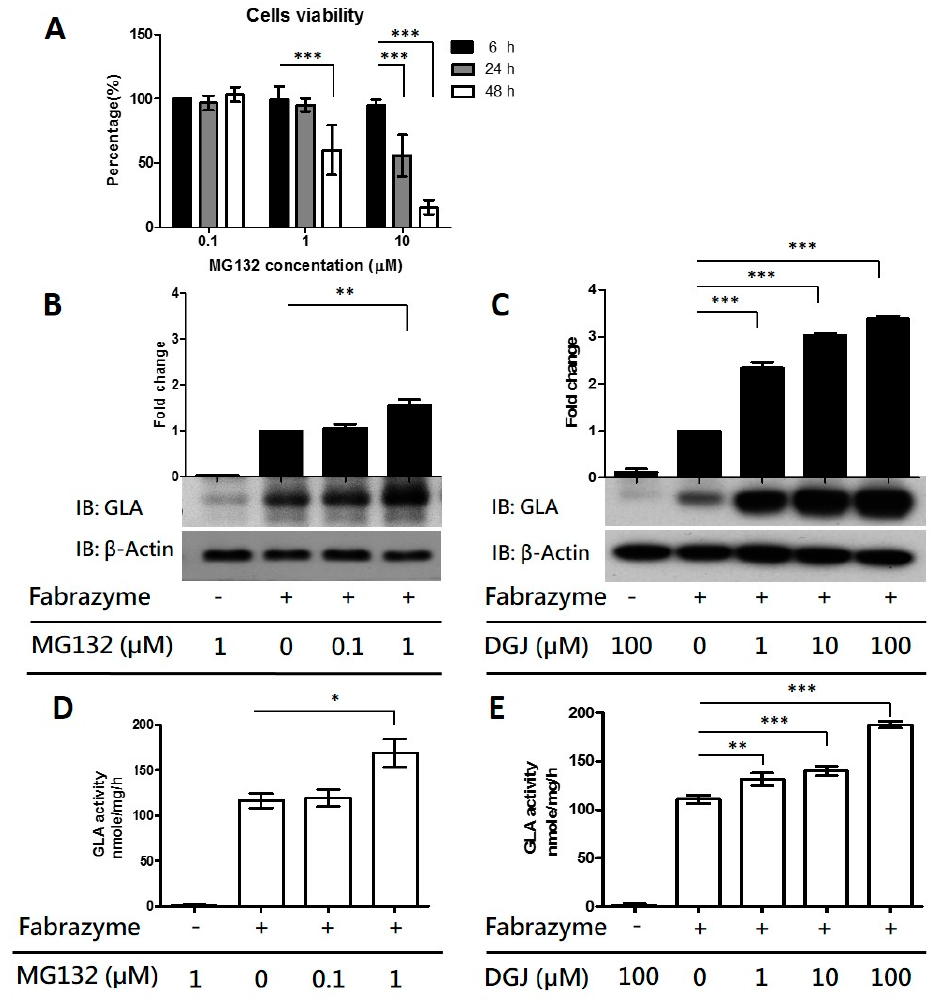
Figure 3. Co-administration of rh α -GLA and MG132 increases the enzyme activity and protein stability of rh α -GLA in vitro. ( A ) Cytotoxicity of proteasome inhibitors MG132 in the GLA-null cells were determined by WST-8 assay followed as the description in “Materials and Methods”. Briefly, the cells were treated with MG132 (0.1, 1, and 10 µ M) for 6, 24, and 48 h. The cell viability of each treatment was determined by comparing with the vehicle control. The data are presented as mean ± SD ( n ≥ 3). *** p < 0.001 vs. the 6 h post-treatment; ( B ) Following co-treatment of MG132 (0.1 and 1 µ M) with or without 0.1 µ M Fabrazyme for 24 h, the medium was refreshed, and the cells were cultured for another 24 h. Protein levels of rh α -GLA were determined by using immunoblot analysis with β -actin as loading control. Representative immunoblot data are presented. Relative levels of rh α -GLA protein were quantified by densitometry scanning; results are presented as mean ± SD ( n = 3). ** p < 0.01 vs. the treatment controls (MG132 = 0 µ M); ( C ) In following the treatment schedule, the GLA-null cells co-treated with 1-deoxygalactonojirimycin (DGJ) (1, 10, and 100 µ M), with or without 0.1 µ M Fabrazyme, were collected for immunoblot analysis of the rh α -GLA protein levels. Representative immunoblot data are presented, and the quantitative results are presented as mean ± SD ( n = 3). *** p < 0.001 vs. the treatment controls (DGJ = 0 µ M). The corresponding GLA enzyme activity in the cells co-treated with MG132 ( D ) and DGJ ( E ) was determined respectively. Data are presented as means ± SD ( n ≥ 3). * p < 0.05, ** p < 0.01, and *** p < 0.001 vs. the treatment controls (MG132 or DGJ = 0 µ M, respectively). ”+” and “-“ represented the cell treatment with and without Fabrazyme administration,